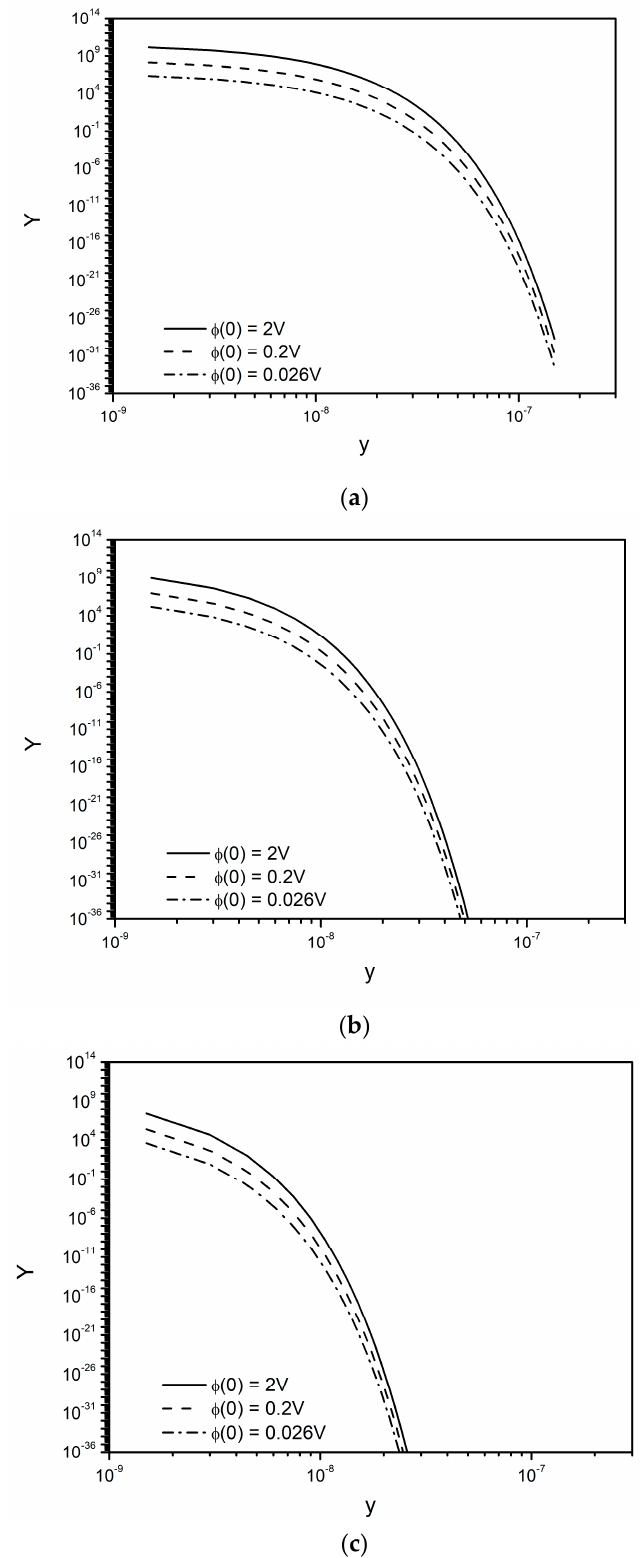
Figure 7. Effect of the nonlinearity on Y along y for various ϕ ( 0 ) at C M = 8.6 mol/m 3 ( a ), C M = 100 mol/m 3 ( b ) and C M = 400 mol/m 3 ( c